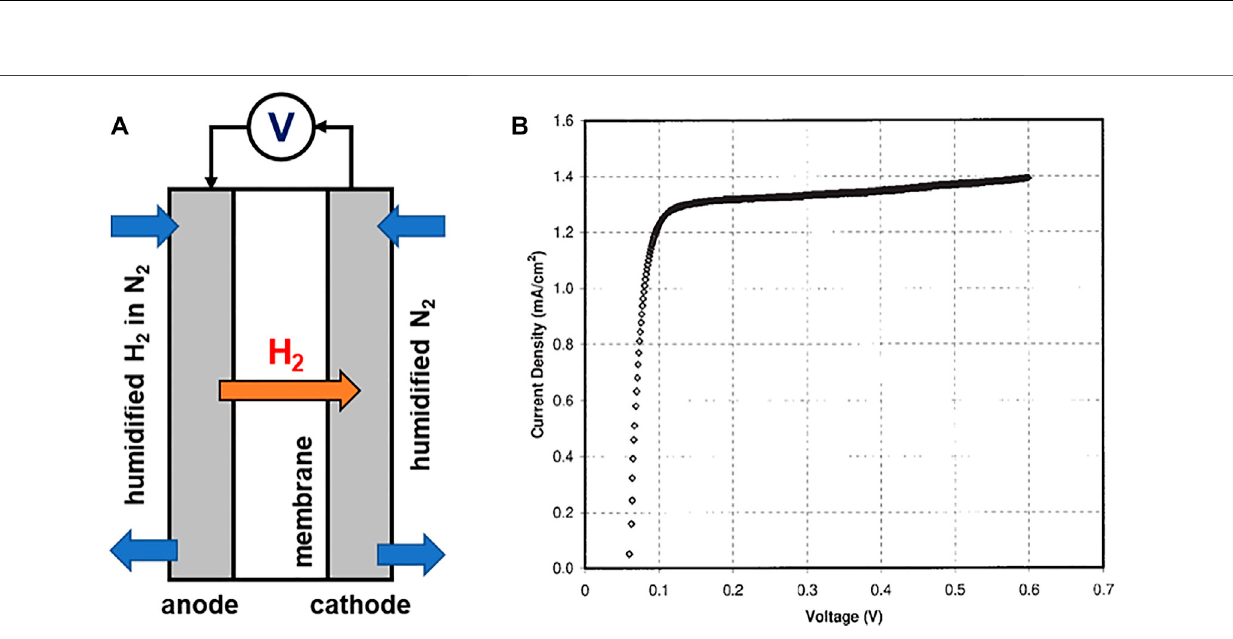
Frontiers in Energy Research |